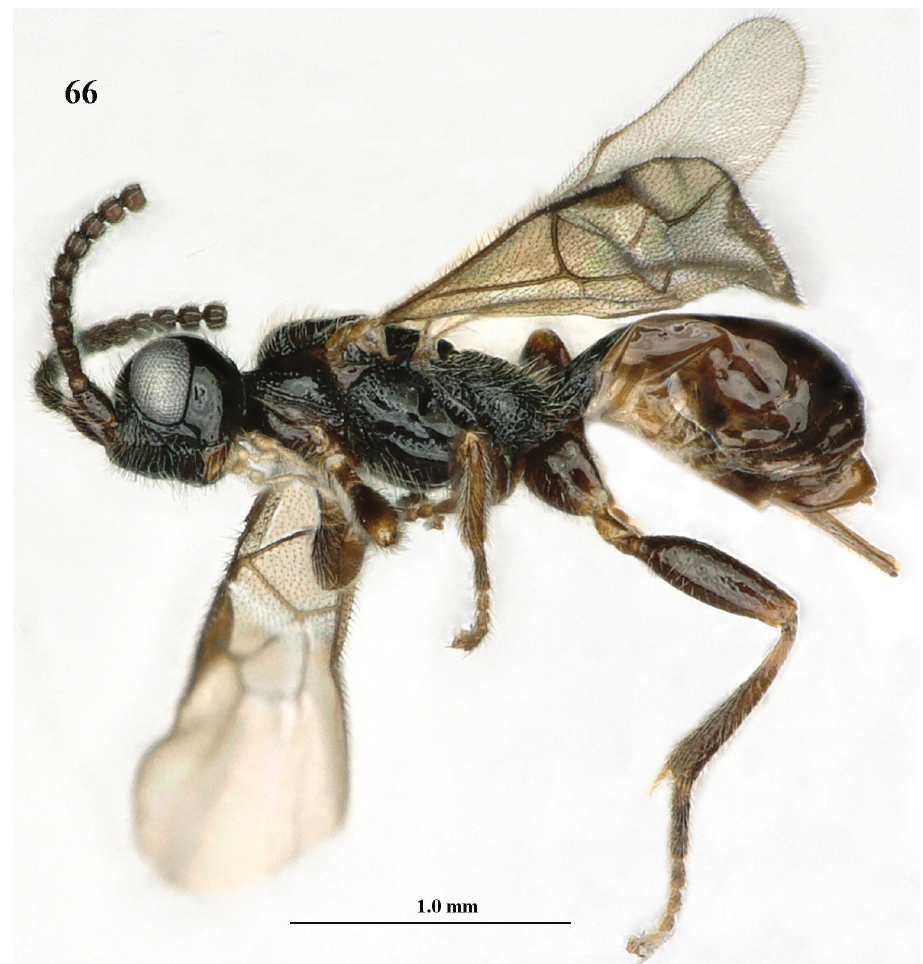
Figure 66. Paramannokeraia juliae gen. n. & sp. n., ♀ , holotype, habitus, lateral aspect. Description. Holotype, ♀ , length of fore wing 2.5 mm, and of body 2.7 mm. Head. Antenna with 19 segments, length of third segment 1.1 times fourth seg- ment, third, fourth and penultimate segments 1.6, 1.4 and 0.9 (without pedunculus 0.8) times as long as wide, respectively (Fig. 72) and with apical 12 segments pedun- culate, medially antenna as wide as apically; length of maxillary palp 0.8 times height of head; occipital carina complete, low dorsally (Fig. 75); eye 1.5 times as long as tem- ple in dorsal view; temples subparallel-sided behind eyes; OOL:diameter of posterior ocellus:POL = 9:5:11; frons smooth and shiny, with some long setae, convex, with shallow median groove, and anteriorly flattened; face with some rugae dorsally below antennal sockets and remainder sparsely coarsely punctate (Fig. 73); clypeus